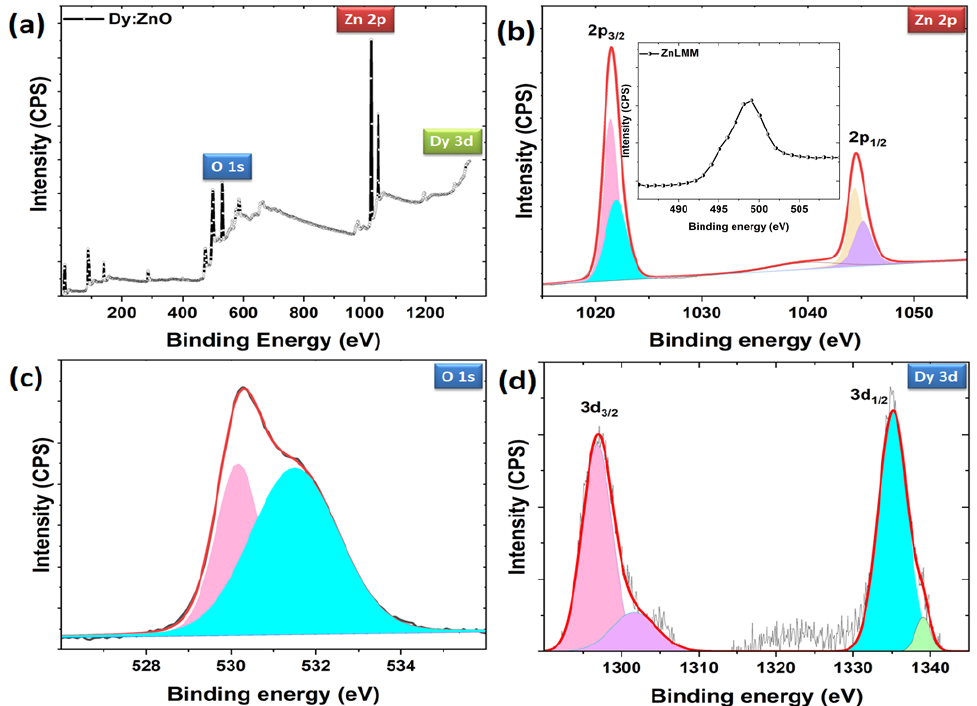
Figure 7. ( a ) Survey scan XPS spectrum for Dy doped ZnO nanoparticles and de-convoluted core level spectra for ( b ) Zn 2p, ( c ) O 1s, and ( d ) Dy 3d level.